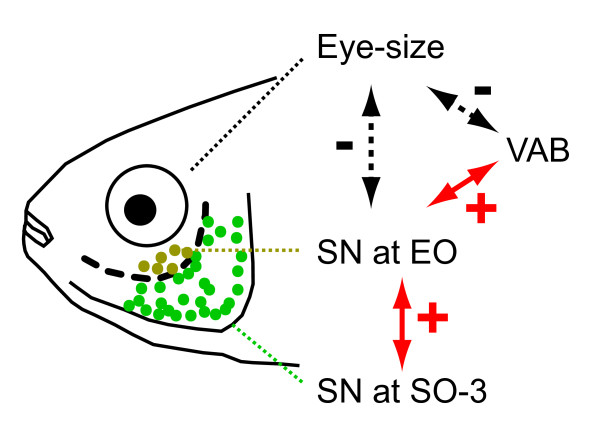
Schematic diagram showing correlations among four traits examined in this study. Yellow and green dots represent EO SN and SO-3 SN, respectively. Red arrows indicate significant positive correlations (denoted by "+"), shown in this study and previous studies [27]. The statistics of positive correlation between EO SN and SO-3 SN were r = 0.24, P < 0.001, n = 247. Black arrows with dotted lines indicate significant negative correlations (denoted by "-") determined in the present study.